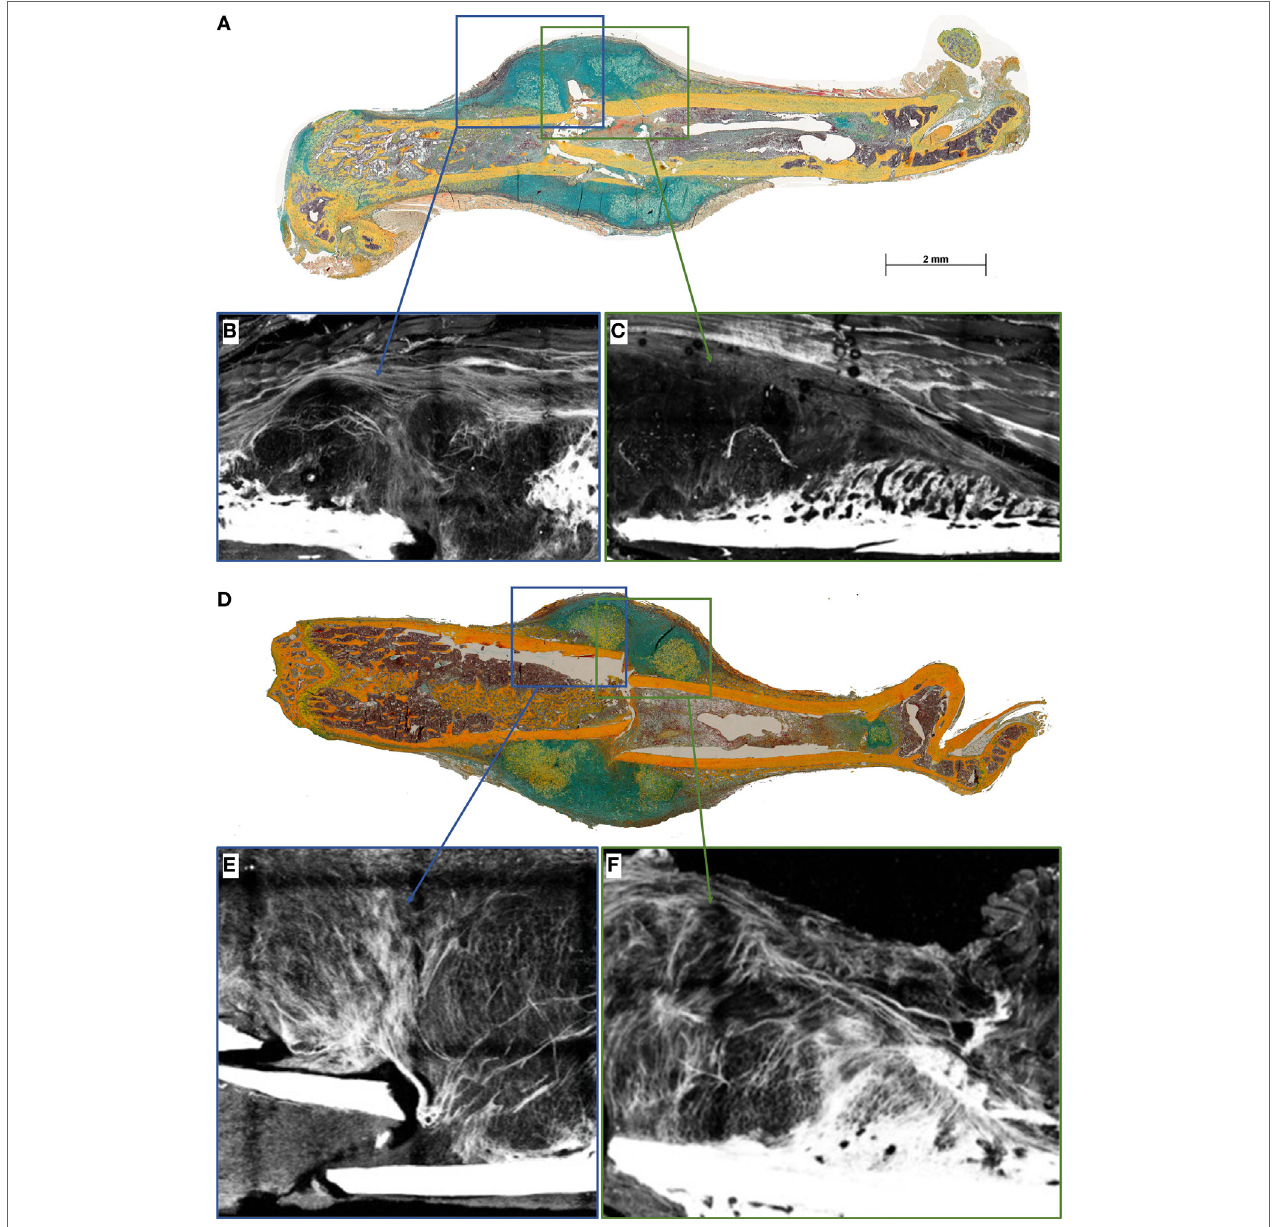
FigUre 4 | collagen fibril deposition appears disorganized in recombination activating gene 1 homozygous knockout (rag1 − / − ) animals’ callus at day 7 (D7) . Seven days after fracture the callus was imaged to analyze the collagen deposition pattern in wild-type (WT) mice (a) and RAG1 − / − mice (D) . WT animals show an aligned structure of collagen fibrils (B) in the callus and on the periosteal surface (c) , the imaging also shows structurally sound woven bone on the periosteal surface. Disarrangement of collagen fibrils structure was apparent in the RAG1 − / − callus (e) , and periosteal bundle arrangement is seen with dense mineral deposition in the periosteal surface without woven bone structure (F) . This representative image shows the disorganized collagen deposition occurring without mature T and B cells in the RAG1 − / − animals. (Blue rectangles show the central area of the fracture callus while the green outtakes concentrate on the margin and thus periosteal callus